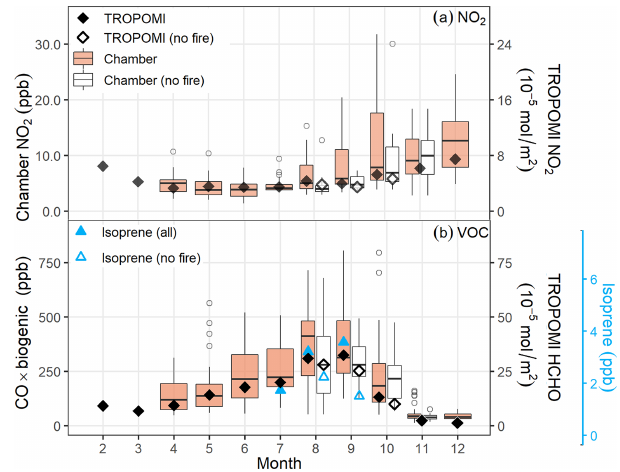
Figure 2. Monthly concentrations of NO 2 (a) and CO × biogenic/HCHO/isoprene (b) from February to Decem- ber 2020. Ground-based chamber measurements use the left axis with results shown as box-and-whisker plots. TROPOMI measure- ments use the right axis and are shown as diamonds. Isoprene from the ground monitoring station is shown as blue triangles. The open box and points show the results after removing wildfire